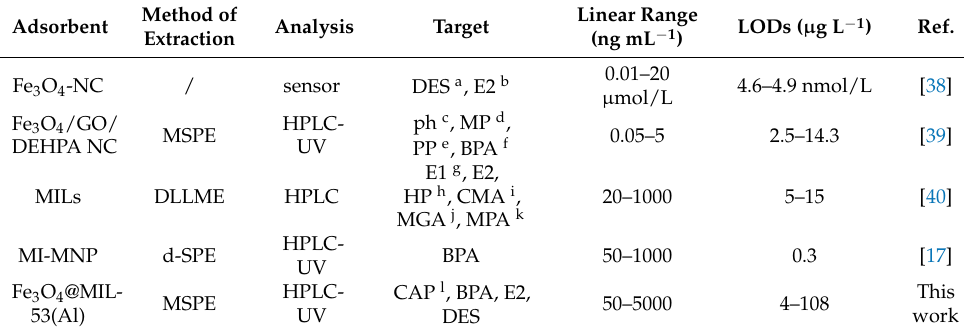
Table 2. Comparison of proposed method wit reported